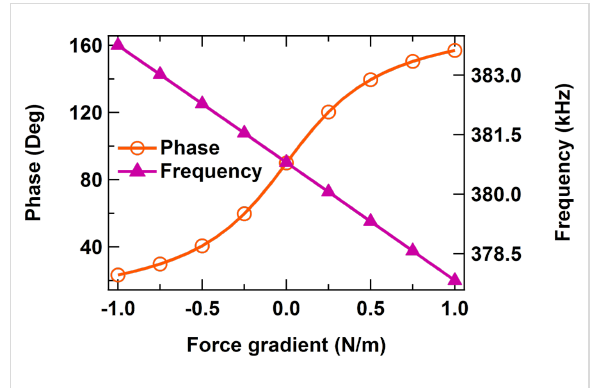
Figure 2: Phase and frequency shift calculated analytically for a higher eigenmode with f 2 = 380.8 kHz, k 2 = 64.2 N/m and Q 2 = 450 as a func- tion of the effective tip–sample force